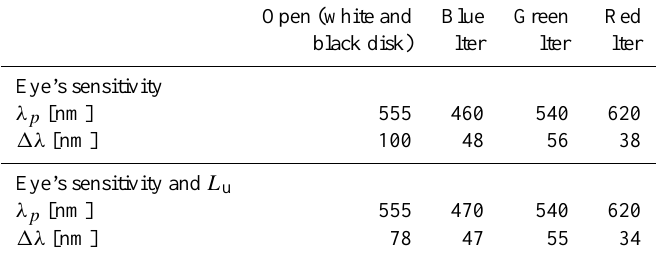
Table 2. Wavelength λ p of peak value and half-peak bandwidth 1λ of the eye’s photopic sensitivity, alone and in combination with the upward spectral luminance L u ; for the open eye and with filters for the white disk (Mikaelsen and Aas, 1990). Open (white and Blue Green Red black disk) filter filter